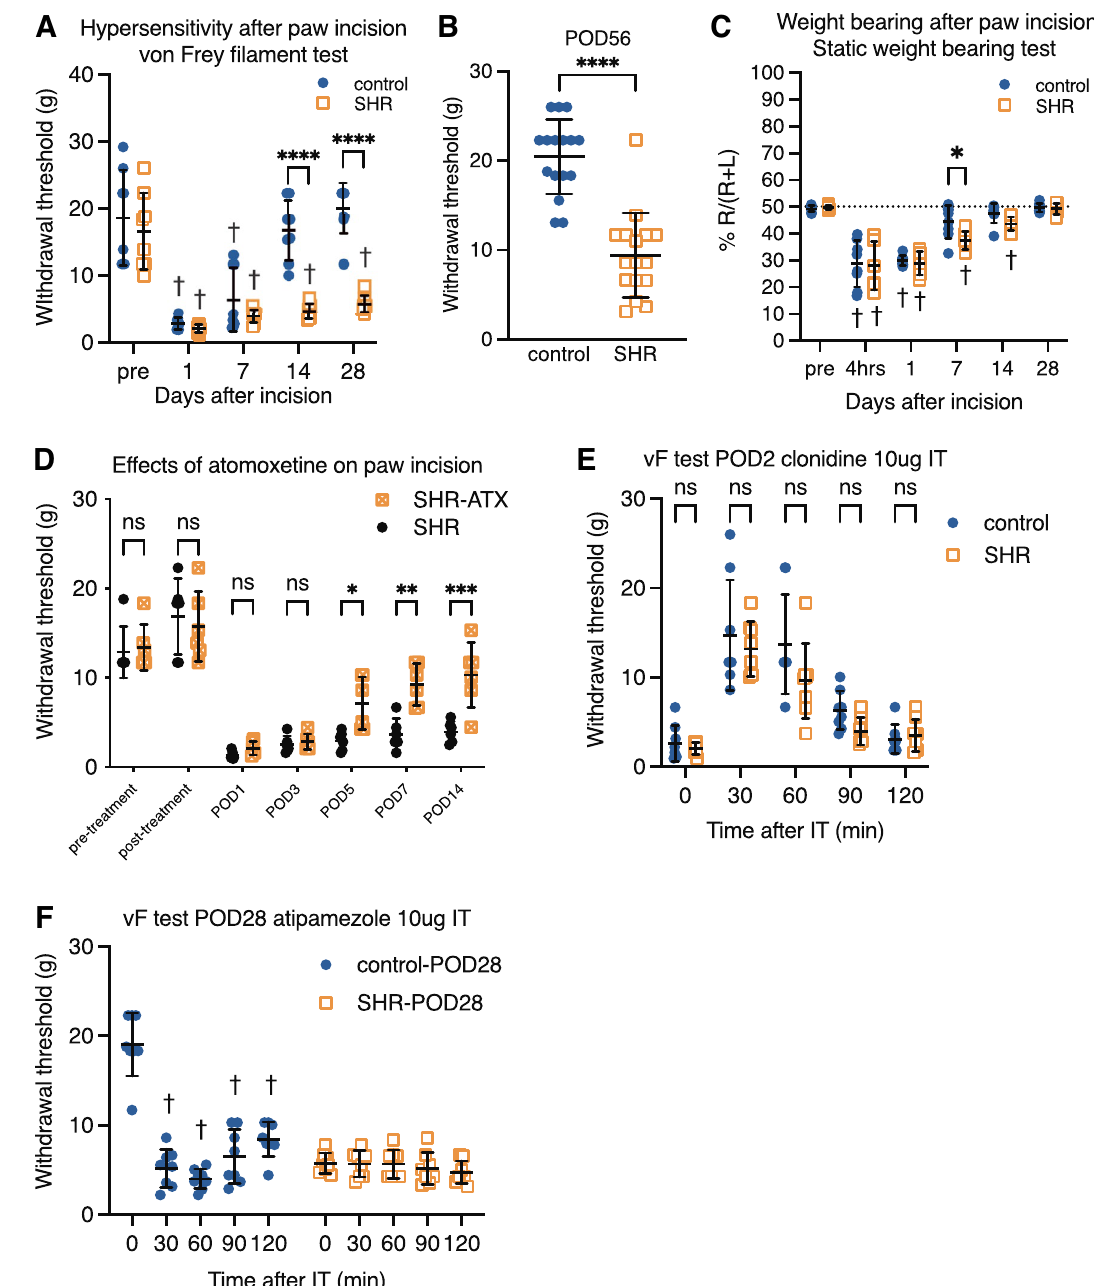
Figure 5. contribution of noradrenergic analgesia to the recovery period after acute incisional pain. The right hind paw incision produced mechanical hypersensitivity in SHR and control. The control animals recovered to pre-surgery values on POD14 ( A ). SHR had a lower withdrawal threshold than the control, even on POD14, POD28, and POD56 ( B ). The static weight-bearing test showed a slight difference between strains on POD7, suggesting that recovery of spontaneous pain behavior after paw incision is slightly delayed in SHR compared with control ( C ). Repeated atomoxetine treatment (0.3 mg/kg/day 14 days) did not change the withdrawal threshold in SHR, but restored delayed recovery after paw incision ( D ). Intrathecal injection of the alpha2- adrenoceptor agonist clonidine (10 μg/10 μl) on the second day after paw incision (POD2) produced anti- hypersensitivity in both SHR and control ( E ). The effect and duration of clonidine did not differ significantly between SHR and control. Intrathecal injection of the alpha2-adrenoceptor antagonist atipamezole (10 μg/10 μl) on POD28 reduced the withdrawal threshold in control, but did not affect SHR ( F ). Mean ± SD, *; p < 0.05, ****; p < 0.0001 versus control, †; p < 0.05 versus pre. †; p < 0.05 versus time 0, ns: not statistically significant. n = 8 each ( A , C , D , E ). n = 16 ( B ). vF: von Frey filament test, POD: postoperative day, IT: intrathecal injection. SHR: spontaneously hypertensive rats (ADHD model), SHR-ATX: atomoxetine treated